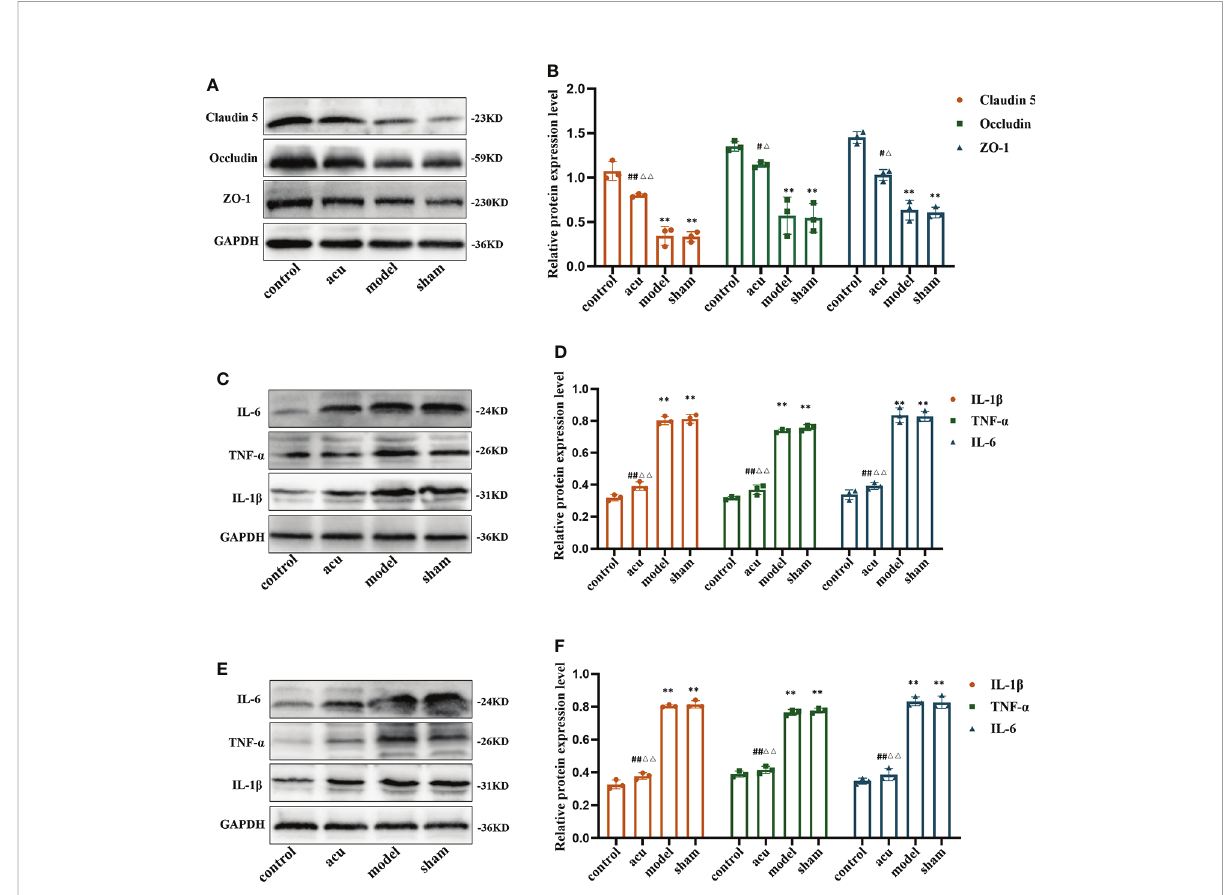
FIGURE 3 Acupuncture treatment ameliorates gut barrier, gut in fl ammation and neuroin fl ammation in CRF mice after chemotherapy for BC. (A, B) The expression levels of tight junction proteins ZO-1, Occludin, and Claudin 5 in gut. (C, D) The expression levels of pro-in fl ammatory factors IL-1 b , IL-6, and TNF- a in the gut. (E, F) The expression levels of pro-in fl ammatory factors IL-1 b , IL-6, and TNF- a in the hippocampus. n = 3 mice in each group. ** P < 0.01 versus control group; # P < 0.05 versus model group, ## P < 0.01 versus model group; △ P < 0.05 versus sham group, △△ P < 0.01 versus sham